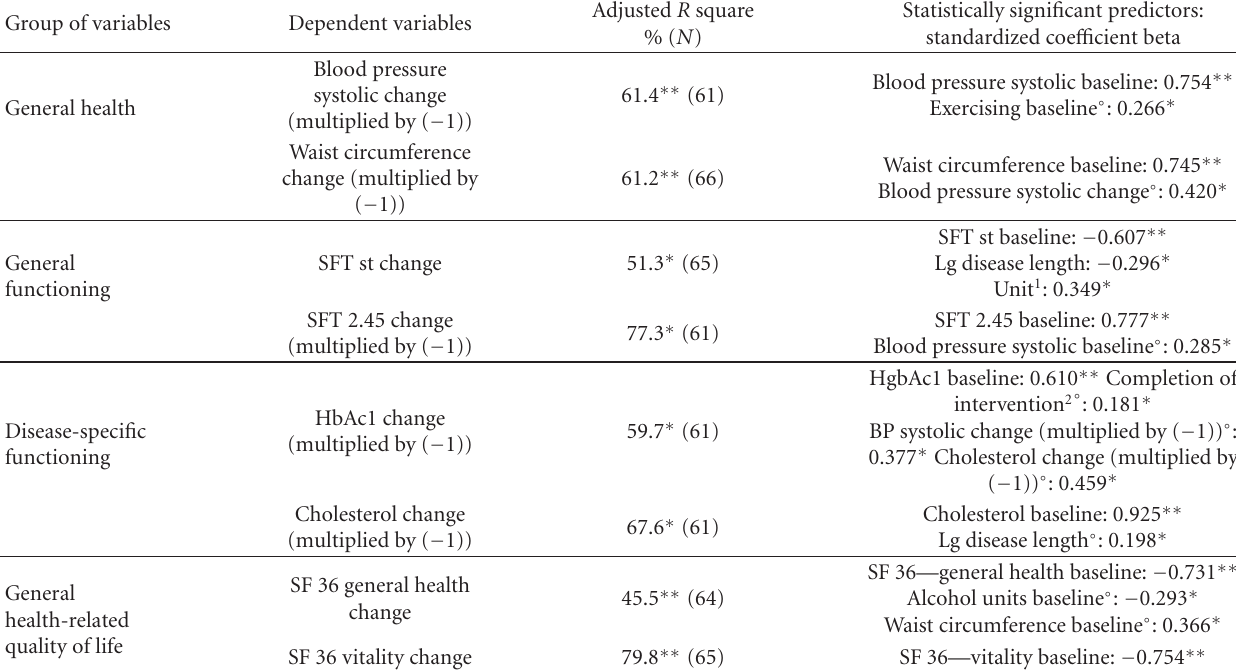
Table 4: Parameters of the multivariable linear regression models to explain intervention e ff